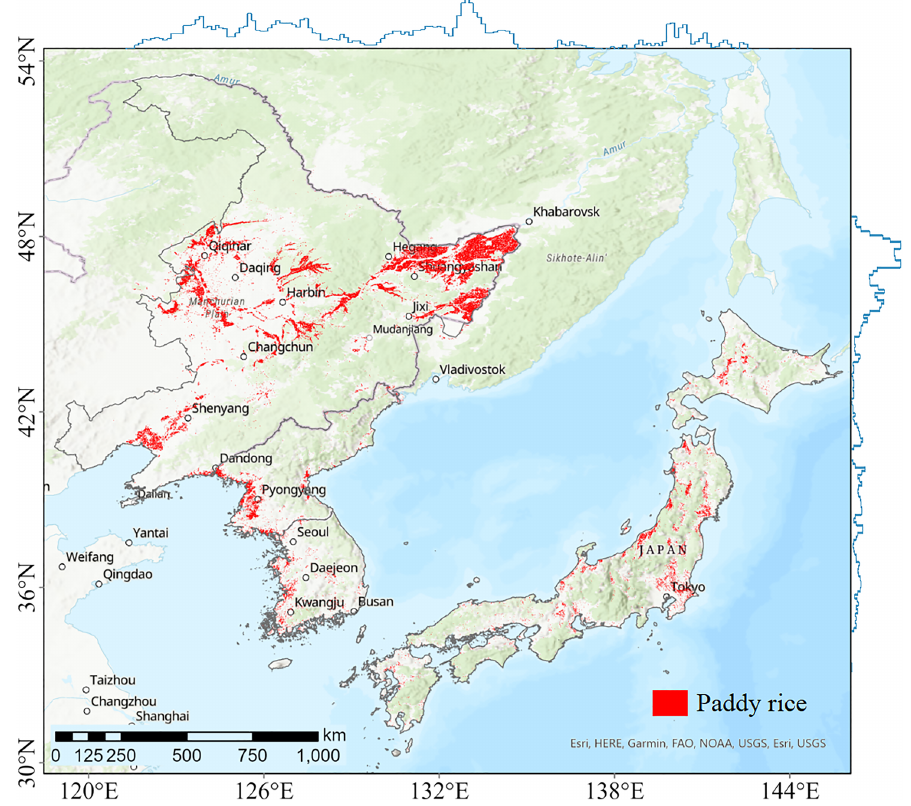
Figure 7. Spatial distribution of classified composite paddy rice with a 10m spatial resolution in NE Asia during 2017–2019. The curves represent the relative change rate in the distribution of the number of paddy rice pixels along the longitude and latitude